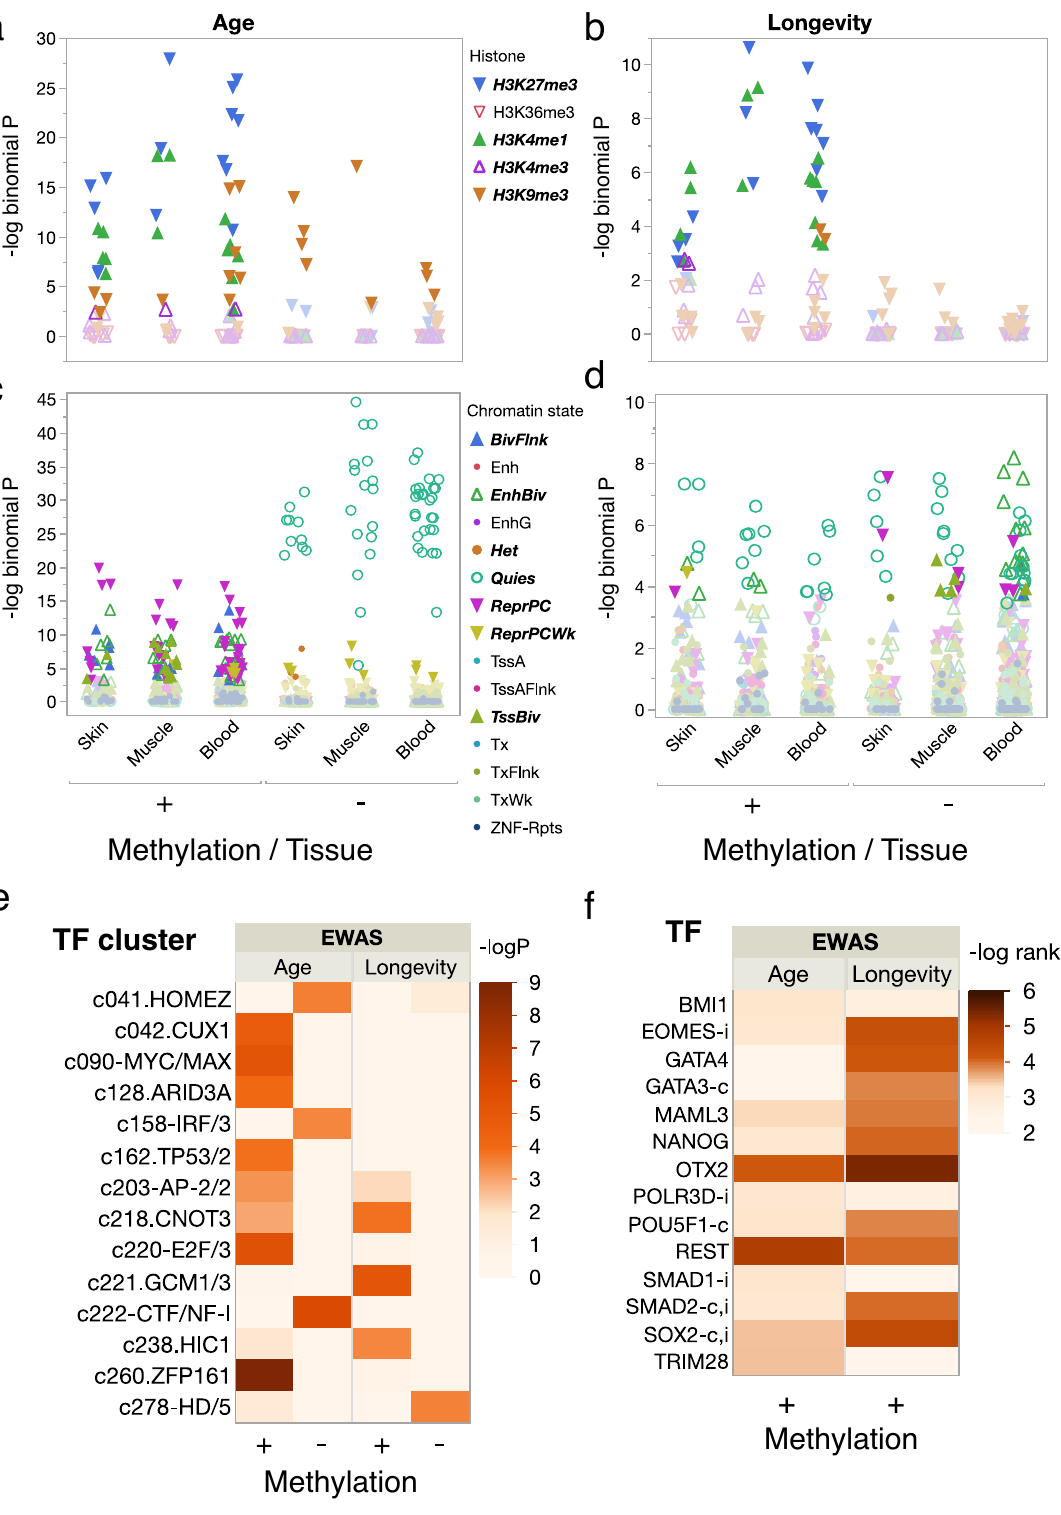
set. By de fi nition, the alpha value for the elastic net regression was set to 0.5 (midpoint between Ridge and Lasso-type regression) and was not optimized for model performance. We performed two cross-validation schemes for arriving at unbiased estimates of the accuracy of the different DNAm based age estimators. One type consisted of leaving out a single sample (LOO) from the regression, predicting an age for that sample by regressing an elastic net on the methylation pro fi les of all other samples and iterating over all samples. We conducted LOO analyses using all samples from all species, using all samples from each species and